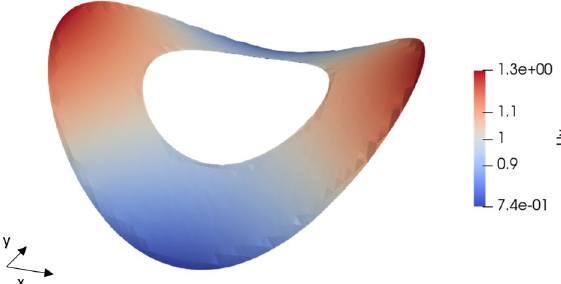
Fig. 24 Elevation of the numerical